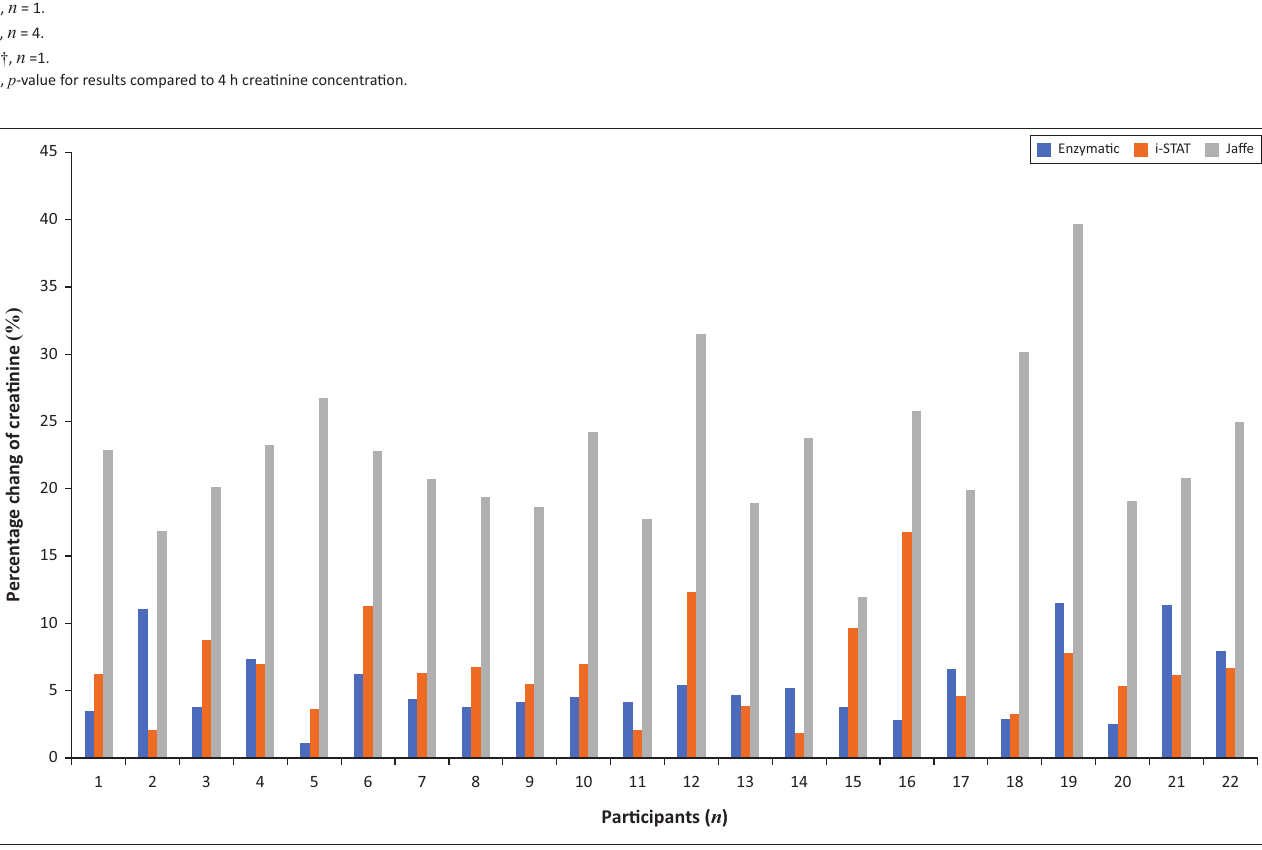
TABLE 1: Creatinine concentrations for the study cohort ( n = 22) obtained using the enzymatic, kinetic Jaffe method and i-STAT methods at six different time intervals. Time interval